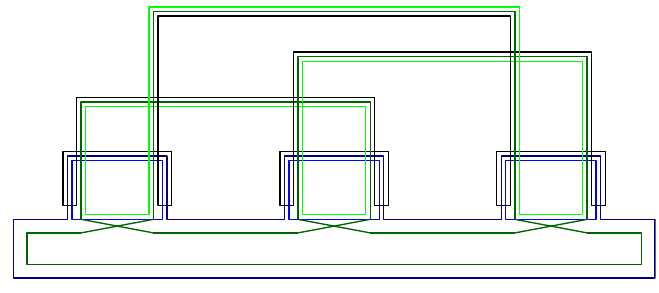
Figure 4 . The negativity moment is given by the sum over all contractions of this diagram.